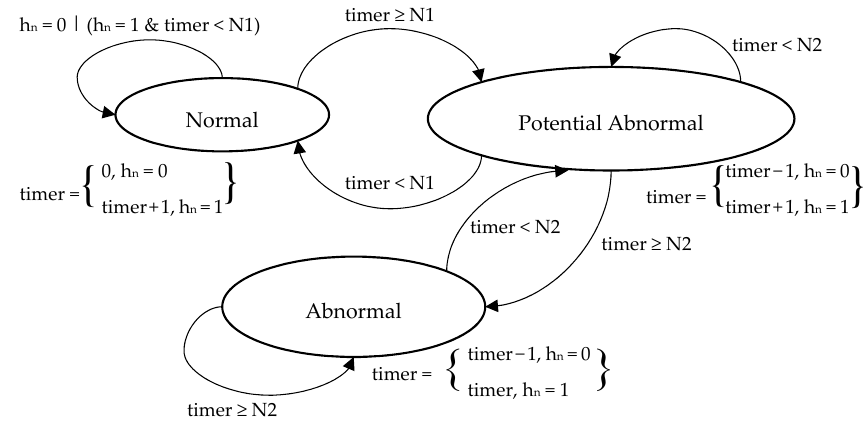
Figure 5. Detection Module—Automaton.